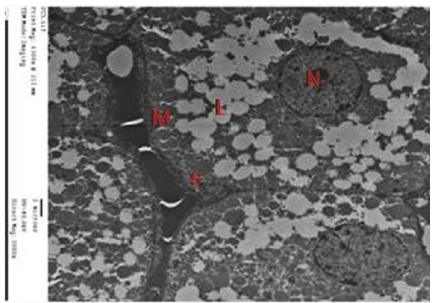
Figure 11: An electromicrograph of control zona fasciculata cells showing many mitochondria with vesicular cristae (M), smooth endoplasmic reticulum (S), lipid droplets (L), and a euchromatic nucleus with peripheral clumps of heterochromatin